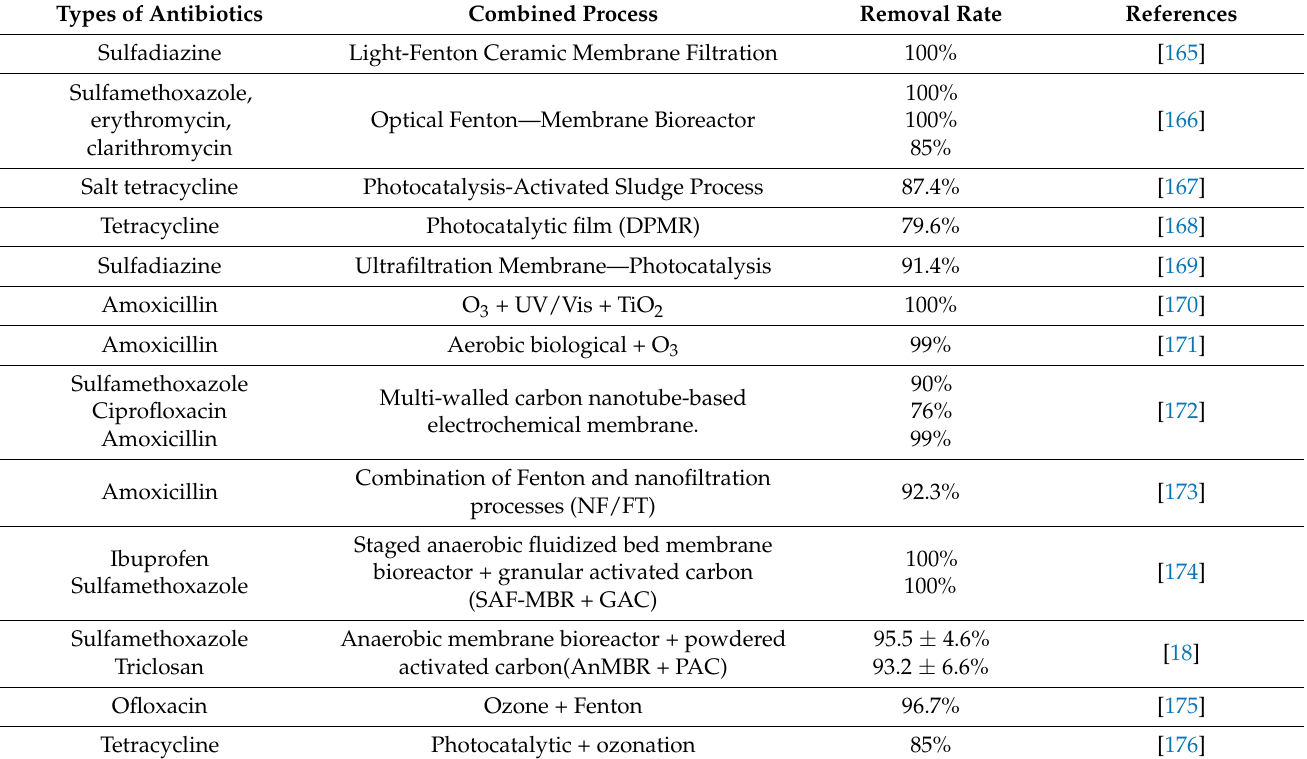
Table 6. The performance of antibiotics removal by using combination